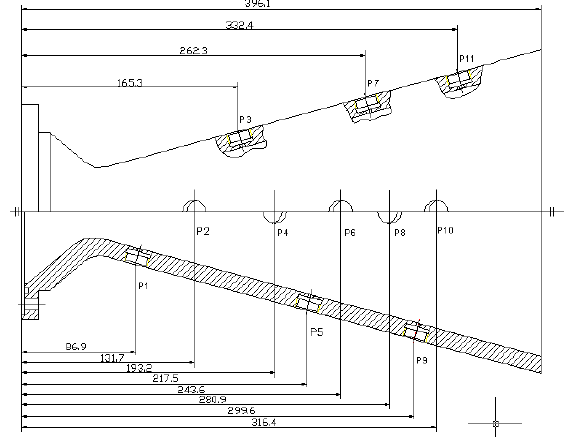
Figure 3. The distribution of the pressure test point.